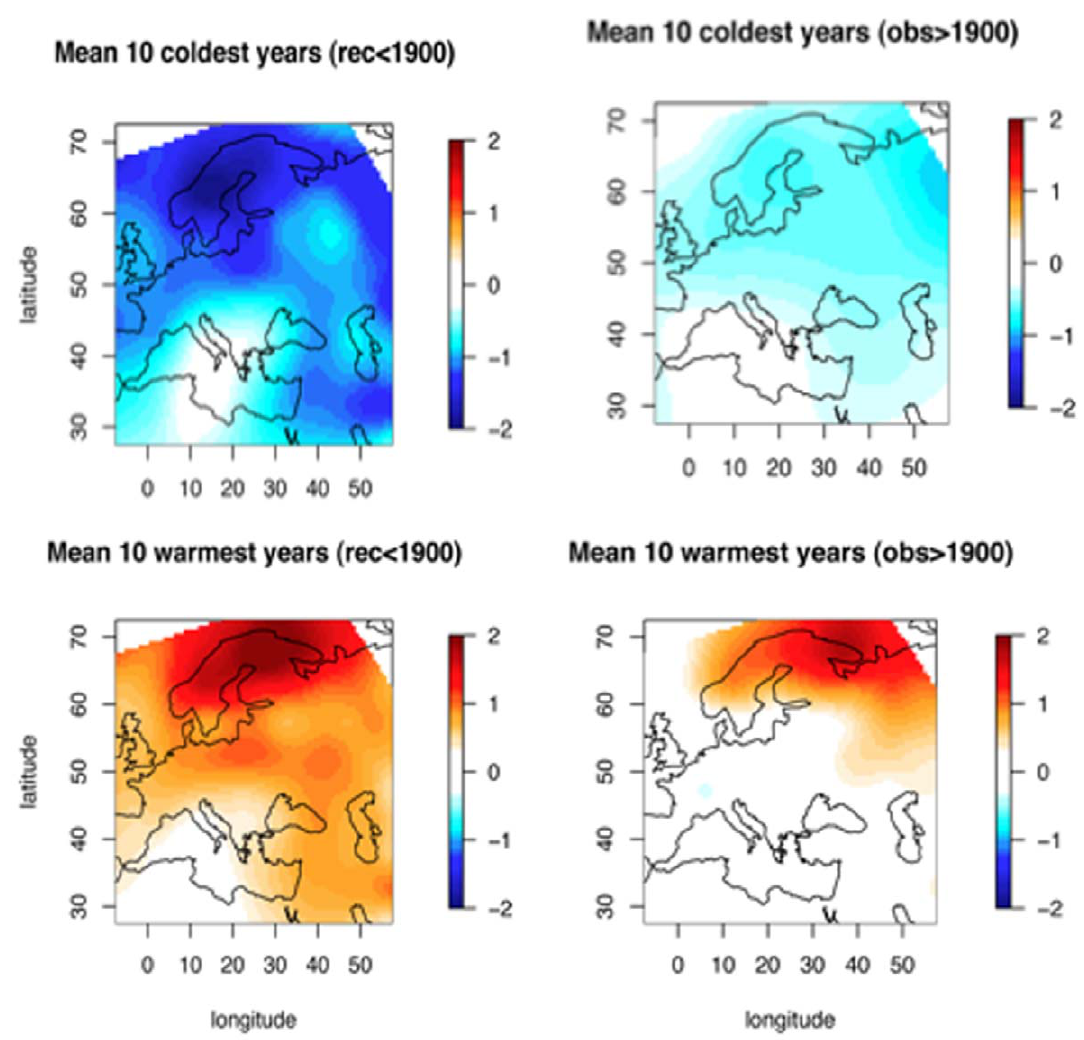
Figure 11. Comparison of extreme years before and after 1900. The upper panel displays the averaged map on the 10 coldest years before 1900 and after; the lower panel displays the 10 warmest years. All values are April to September temperature